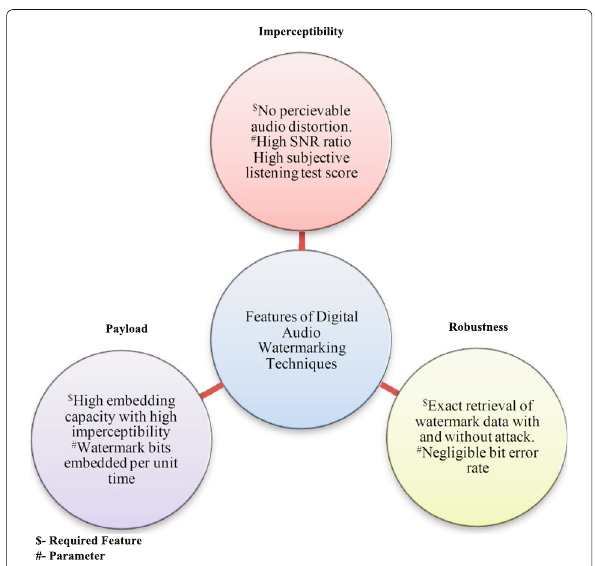
Fig. 1 Performance evaluation factors for audio watermarking techniques